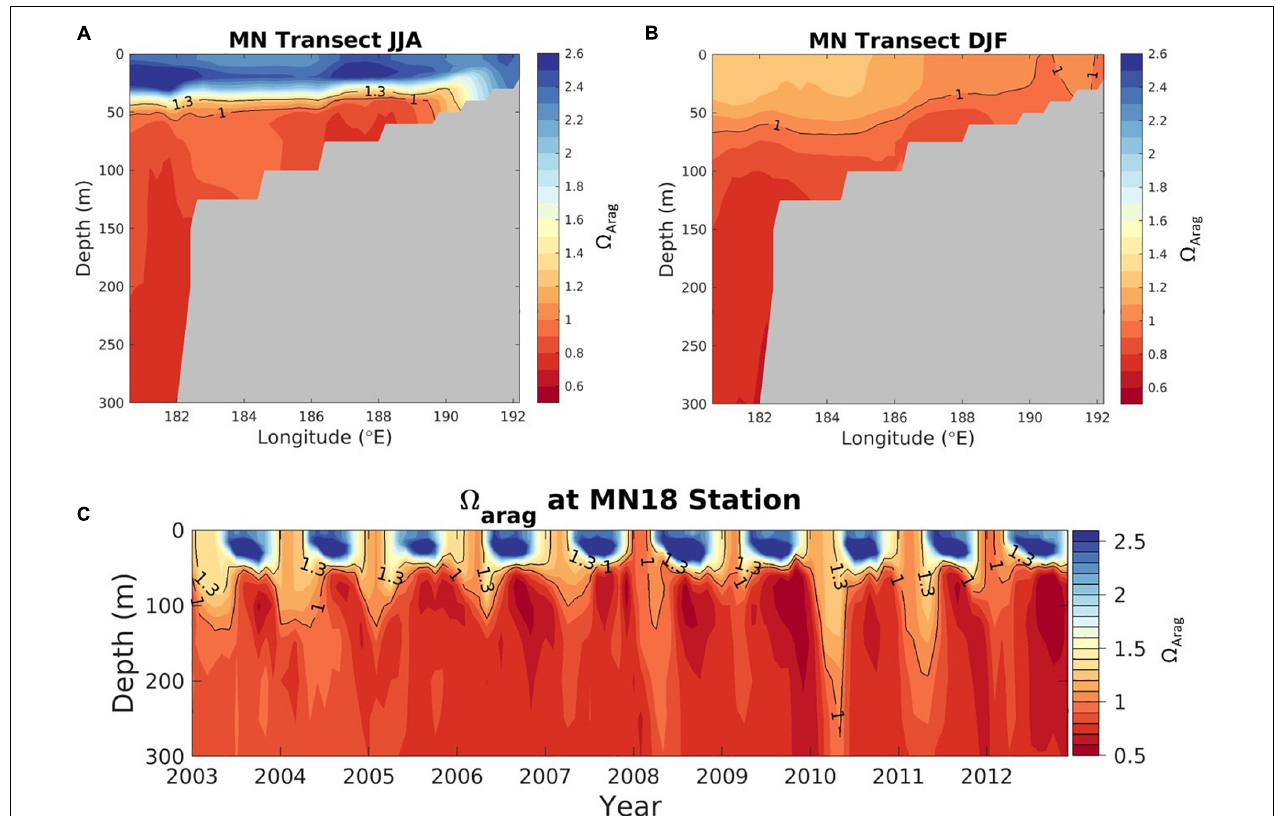
FIGURE 8 | Transect plots of aragonite saturation state ( (cid:127) ar ) in the Bering Sea, along the midnorth (MN) shelf transect line, denoted by the magenta line in Figure 7 , for (A) June July August (JJA) and (B) December, January, February (DJF), averaged over 2003-2012 (modeled data). (C) Aragonite saturation state at station MN18 (cyan plus-sign, Figure 7 ) as a function of depth ( y -axis), and time ( x -axis). Model output is from the Bering10K hindcast simulation described by Pilcher et al.